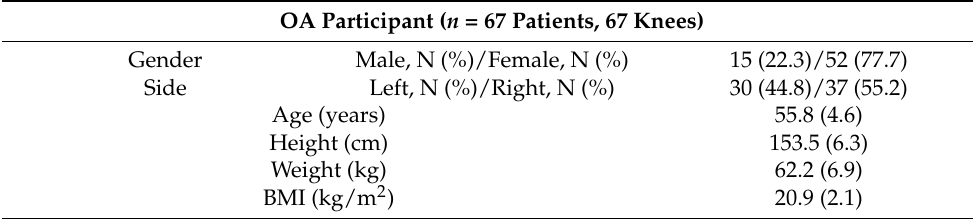
Table 1. Characteristics of the participant. Values are represented as a mean standard deviation (SD) unless otherwise